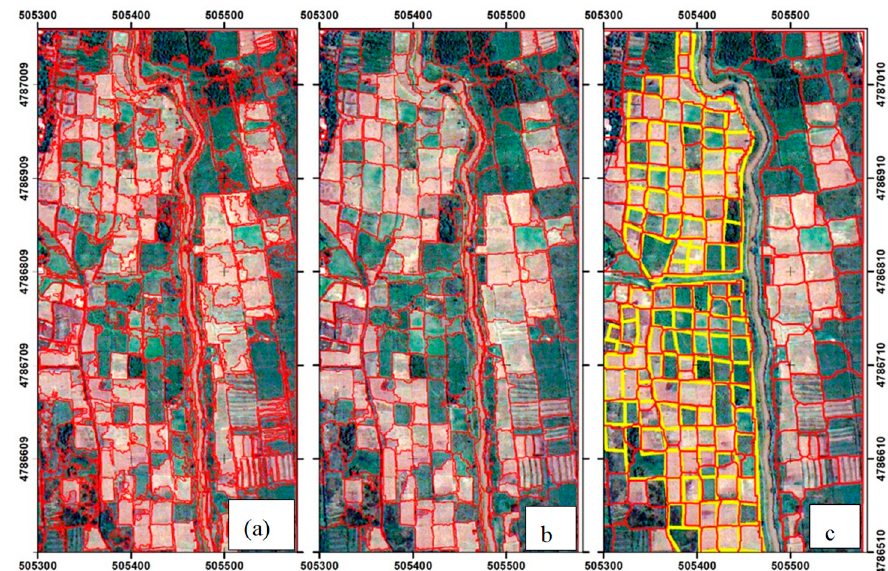
Figure 7. Automatically extracted parcels boundaries: ( a ) result of the automated Estimation of Scale Parameter (ESP2) tool intact; ( b ) results of a modified ESP2 and ( c ) results obtained using expert user-developed rule set. Automated parcels (in red) are overlaid with reference parcels (in yellow).